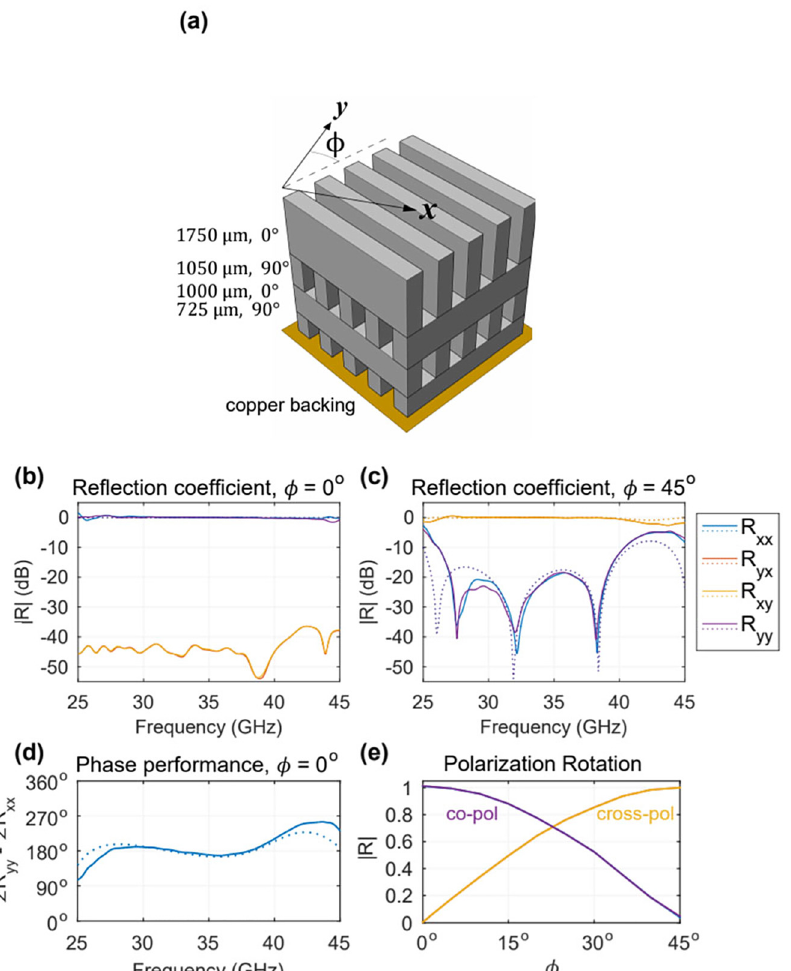
Figure 31: (Reprinted with permission from Ref. [67]). (a) Half-wave plate design and measurement con fi guration. Excitation is atnormalincidencewithlinearpolarization along x and y . The waveplate ’ s fast optic axis is rotated by an angle φ to the y axis. (b) Measured (solid) and analytically calculated (dotted) re fl ection coef fi cients with φ = 0 ° . (c) Measured (solid) and calculated (dotted) re fl ection coef fi cients with φ = 45 ° . (d) Measured (solid) and calculated (dotted) phase performance with φ = 0 ° . Optimal is ∠ Ryy − ∠ Rxx = 180 ° . (e) Polarization rotation at 33 GHz as a function of waveplate angle φ